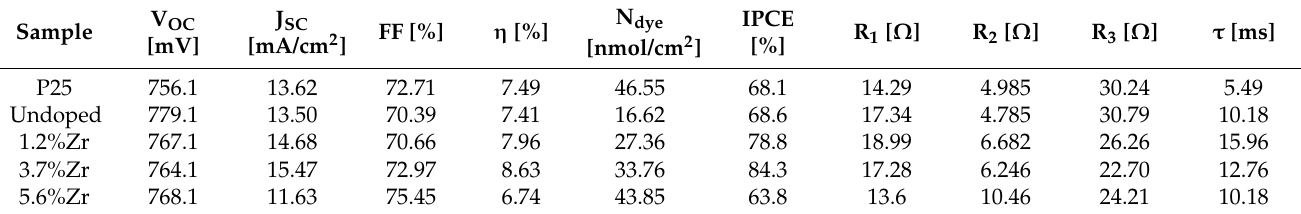
Table 7. Photoelectrochemical parameters of the DSSC based on synthesized nanoparticles.